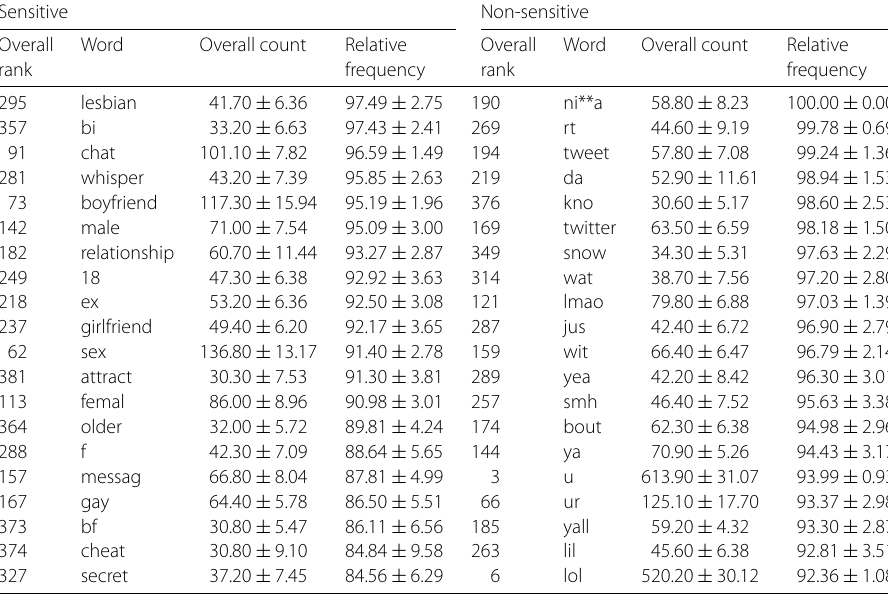
Table 8 Most relevant words for each class in WH + TW Sensitive Non-sensitive Overall rank